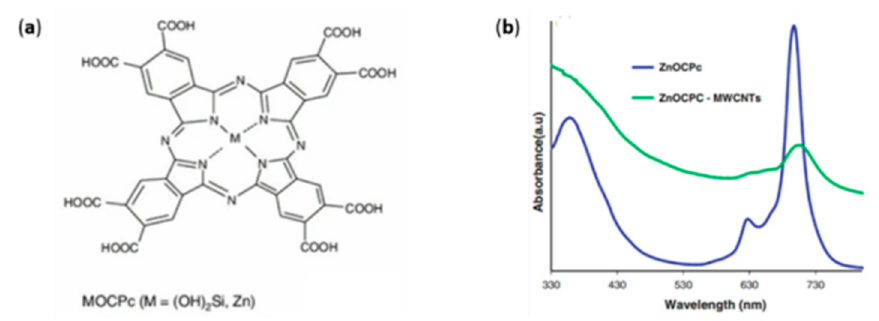
Figure 3. Structure of the MPc ( a ), and absorbance behavior of the pristine ZnPc and its hybrid ( b ). Reproduced from [58] with the permission of the American Chemical